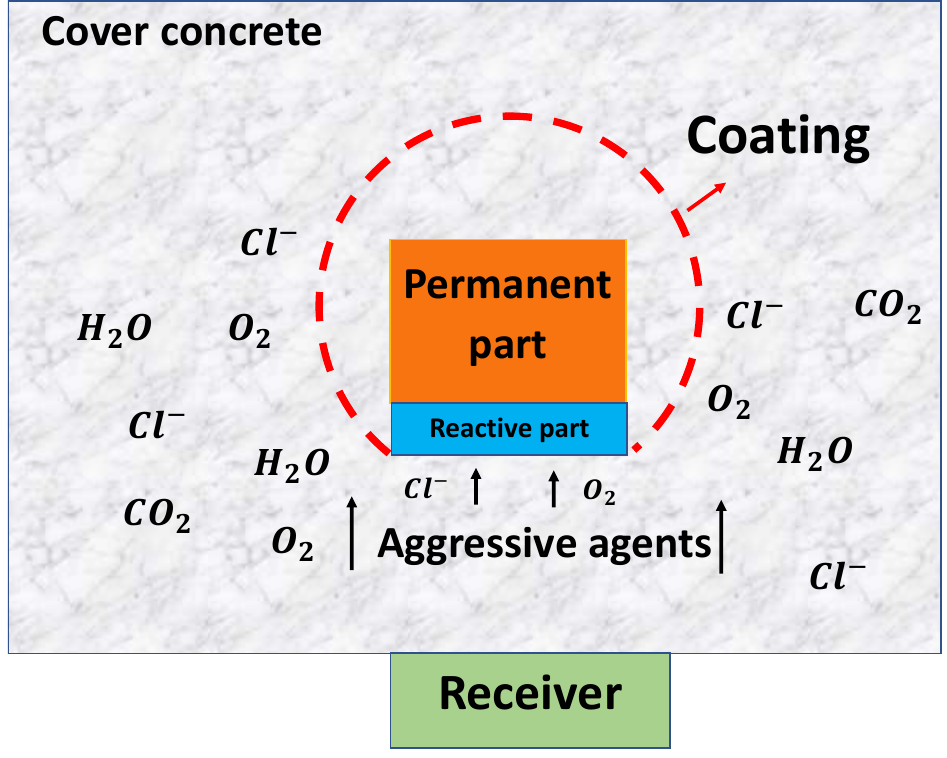
Figure 1. Schematic diagram of an FMM tool in cover concrete and the corresponding corrosion scenario: penetration of water, oxygen, and aggressive agents through concrete cracks into the FMM tool, along with protection of the permanent part against exposure to